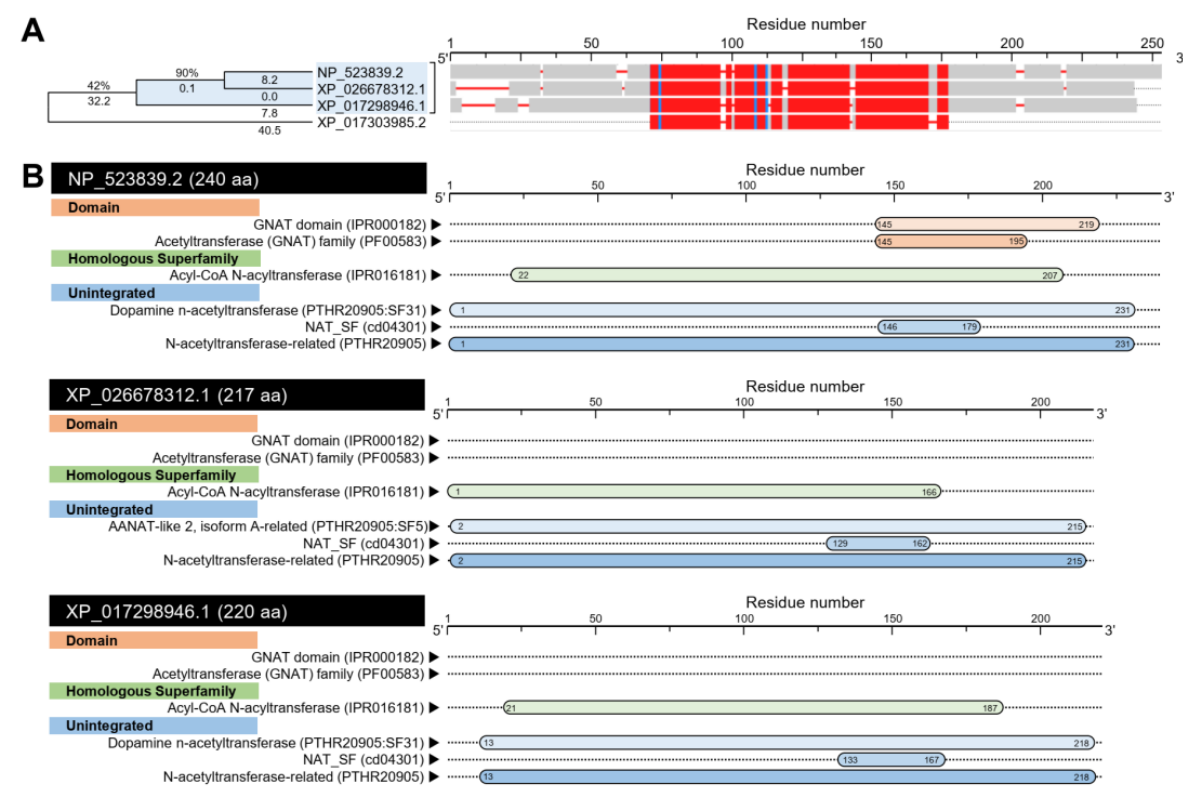
Figure 8. In silico analysis of arylalkylamine N-acetyltransferase ( DcAANAT ) of Diaphorina citri . ( A ) Evolutionary analysis using maximum likelihood method and its associated multiple protein sequences alignments using Constraint-Based Alignment tool (COBALT) analysis. The AA sequences were identified using the Protein–Protein BLAST (BLASTp) using arylalkylamine N-acetyltransferase 1, isoform A ( DmAANAT ; GenBank Accession no. NP_523839.2) from fruit fly, Drosophila melanogaster , as a query sequence, against the Diaphorina citri genome available in GenBank, the national center for biotechnology information website (NCBI, http://www.ncbi.nlm.nih.gov/gene/, 12 February 2021). The tree with the highest log likelihood ( − 2252.02) is shown. The tree is drawn to scale, with branch lengths measured in the number of substitutions per site (next to the branches). The proportion of sites where at least one unambiguous base is present in at least 1 sequence for each descendent clade is shown next to each internal node in the tree. Evolutionary analyses and the joint tree were conducted in MEGA-X software. In the COBALT analysis, residues were colored using a column-based method according to their relative entropy threshold. Aligned columns with no gaps are colored blue and red, where the red color indicates highly conserved columns and blue indicates less conserved ones. ( B ) The protein functional and conserved domains analysis of DmAANAT (NP_612080.1), DcAANAT -1 (XP_026678312.1), and DcAANAT -2 (XP_017298946.1) using InterPro Scan tool (https://www.ebi.ac.uk/interpro/, 12 February 2021). GNAT: GCN5-related N-acetyltransferases and NAT-SF: N-acyltransferase